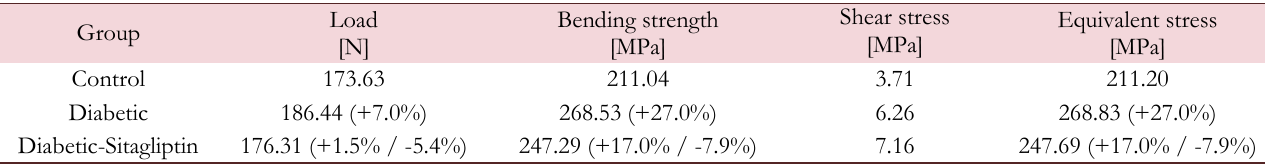
Table 4: The load and the stresses developed in the three groups